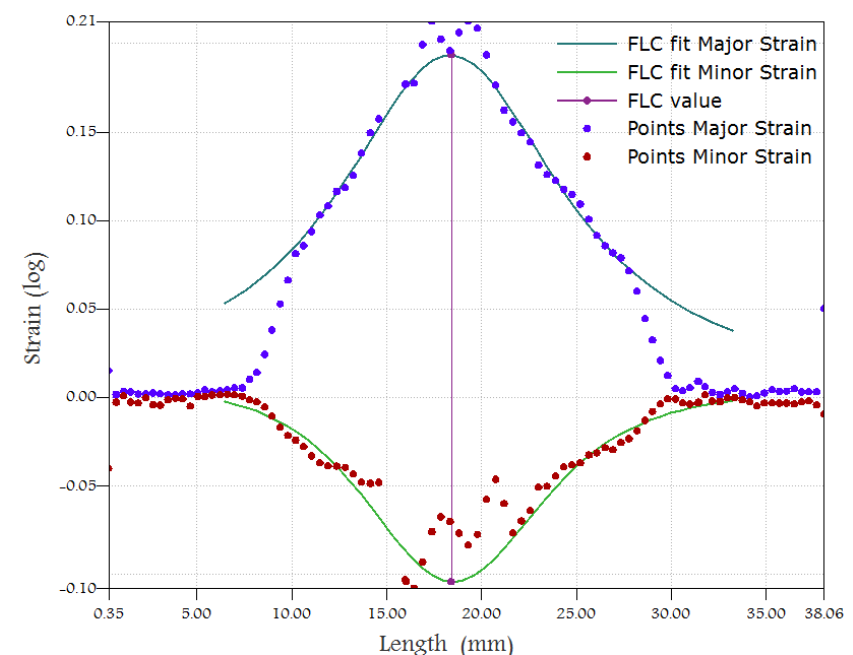
Figure 7. ISO 12004-2 method: major and minor strains as a function of the length for a selected section just before fracture (points) and their fitting with an inverse parabola (full lines). The vertical line gives the major and minor strains of the FLC for this strain